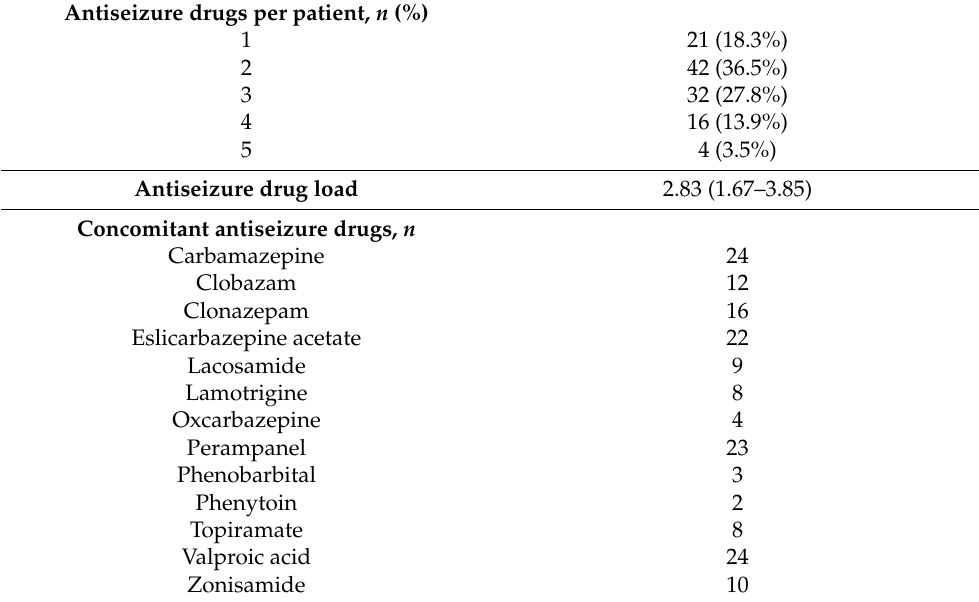
or mean ± standard deviation.